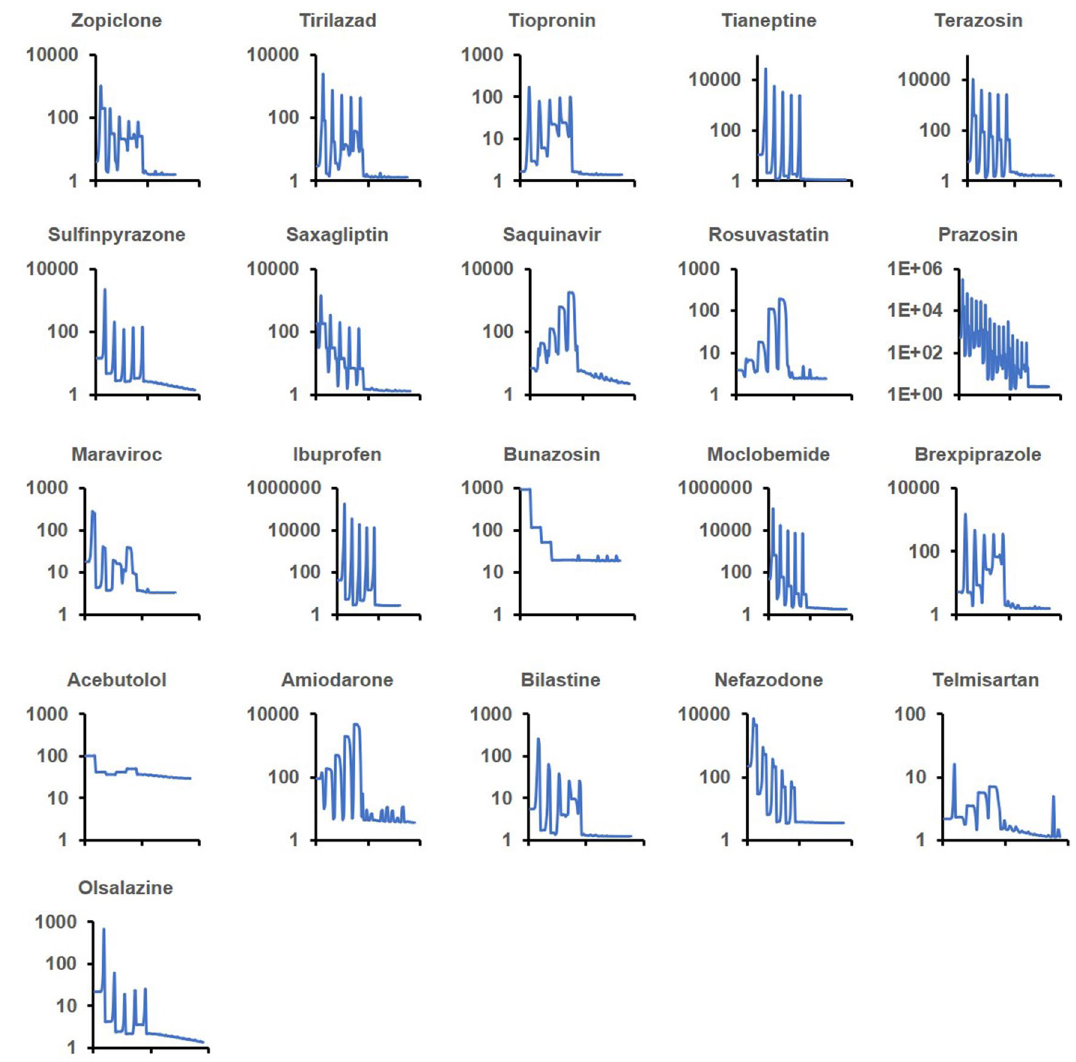
Figure 2. logP optimization convergence plots for 21 small molecule compounds tested with logP optimization. Y-axis corresponds to the cost function; X-axis is the cost progression across grid search optimization (high oscillation) and descent (minimal oscillation) simulation